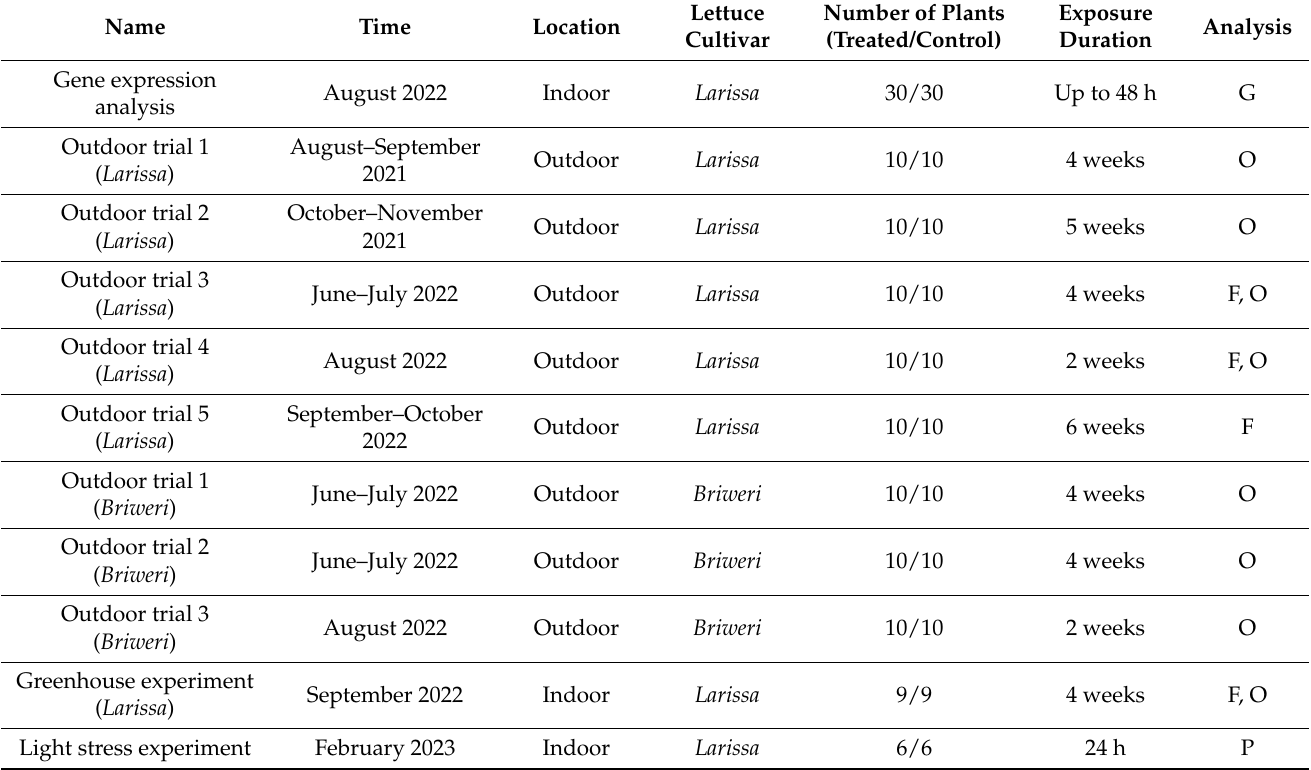
Table 2. Experiments in the study with their time, location, used cultivars, number of plants (treated and control), RF-EMF exposure duration and analysis (G: gene expression analysis; F: flowering time analysis; O: analysis of fast chlorophyll fluorescence OJIP kinetics; P: Imaging PAM